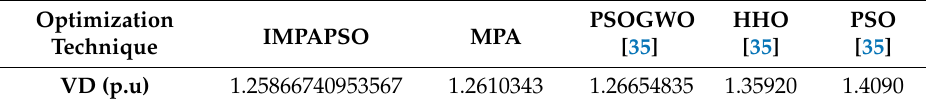
Table 11. IEEE 118-bus system’s second case objective